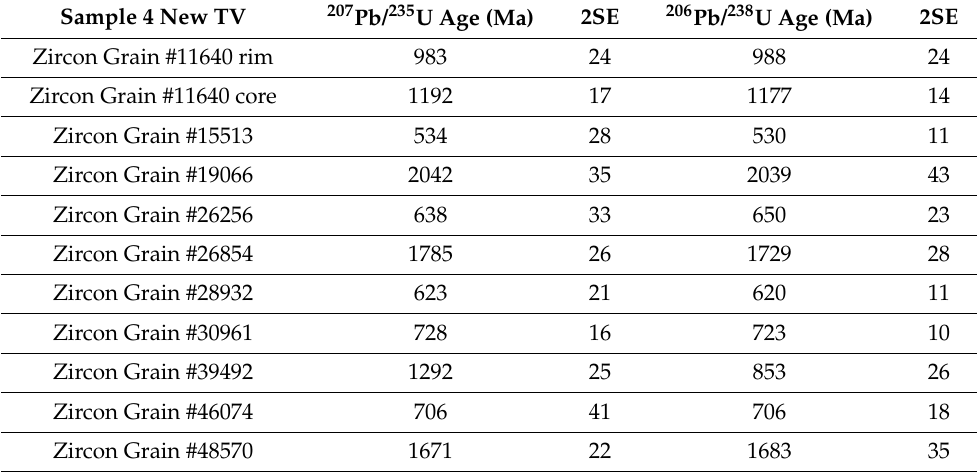
Figure 3. U-Pb Concordia diagram for zircon grains from Sample 4. Table 3. Comparison of MLA calculated assay for sample 2 across the sample prep